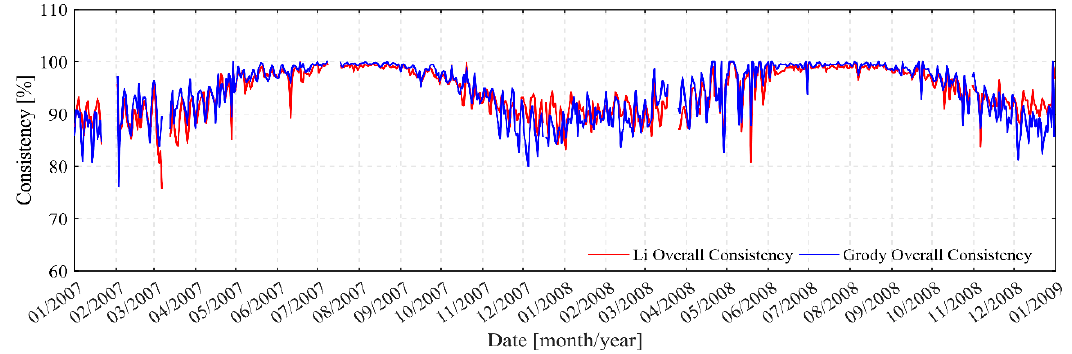
Figure 5. Time series of snow cover detection consistency between SSM / I and SSMIS. Red and blue lines represent Li and Grody’s overall consistency for different satellite Tb inputs, respectively. Table 6. Summary of overall consistency of snow detection method in four seasons. Winter: